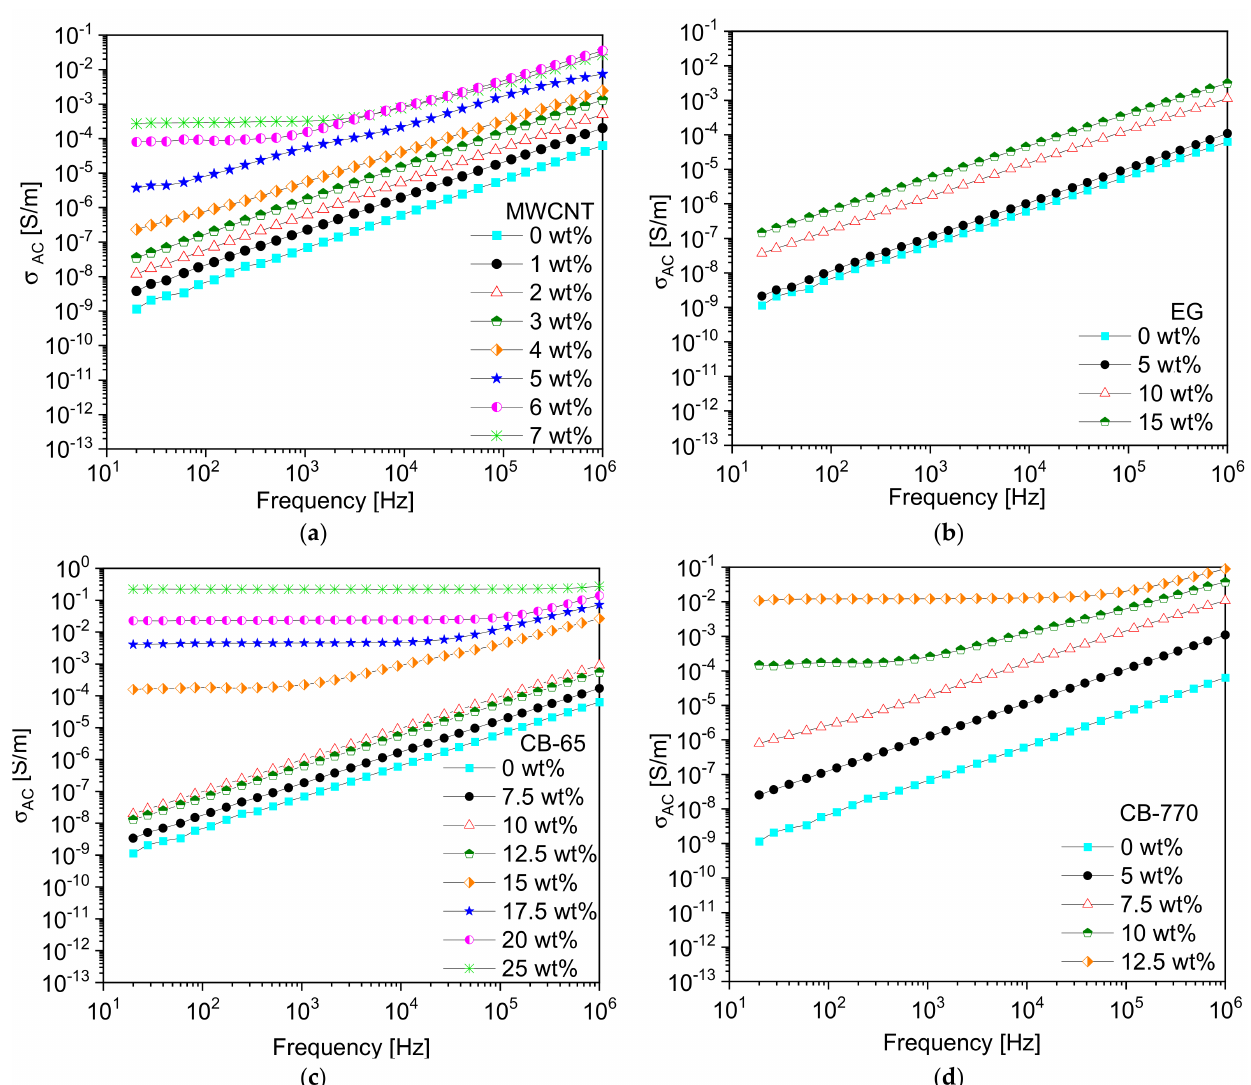
Figure 3. AC electrical conductivity σ AC of ( a ) MWCNT, ( b ) EG, ( c ) CB-65, ( d ) CB-770 nanocomposites,